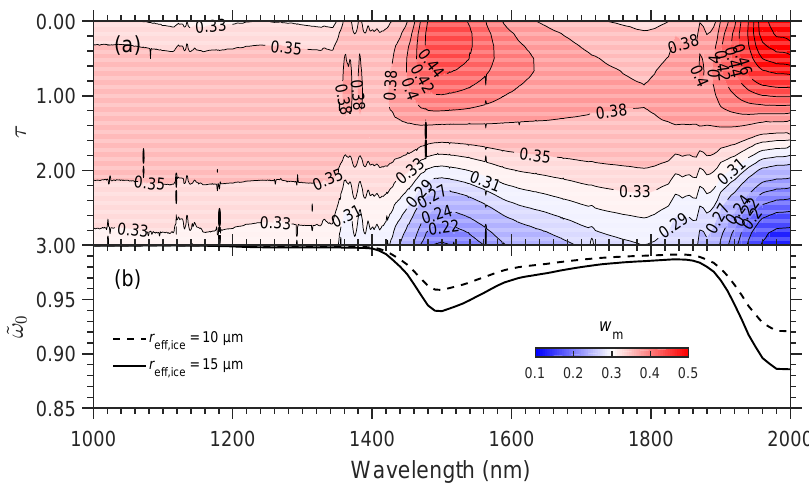
Figure 11. (a) The w m calculated for cloud A at λ = 1000–2000nm. The color represents the weighting. (b) Single scattering albedo e ω 0 of GHM (Baum et al., 2014) with r eff = 10µm (dashed line) and 15µm (solid line).